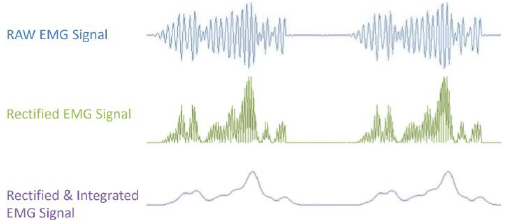
Figure 8. Image that was obtained directly from the Myoware muscle sensor’s datasheet. The obtained electromyographic signals (EMGs) signal is processed before its output.